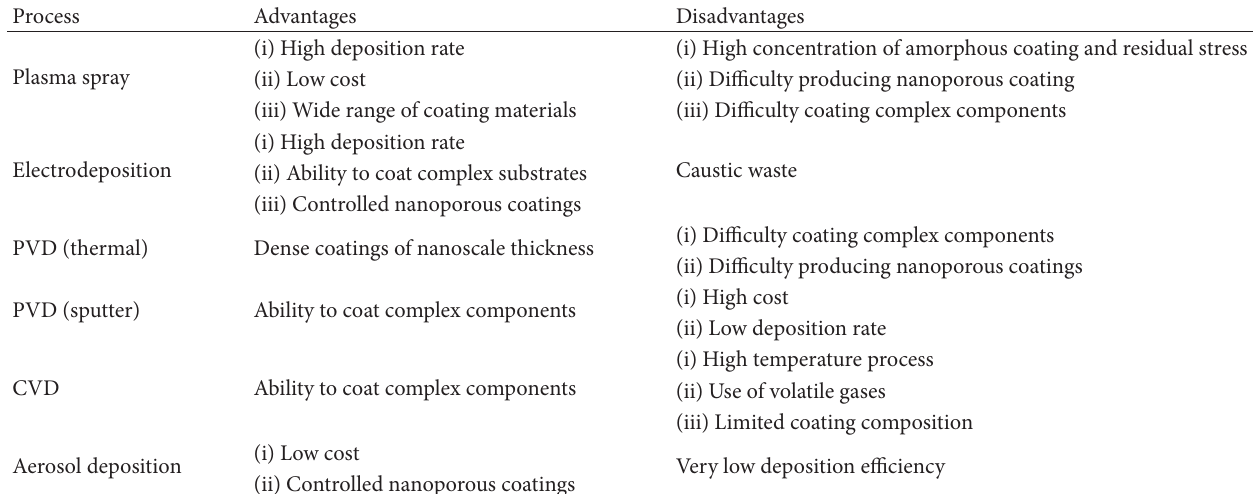
Table 2: A critical assessment of microstructured and nanostructured deposition techniques reviewed in this paper.